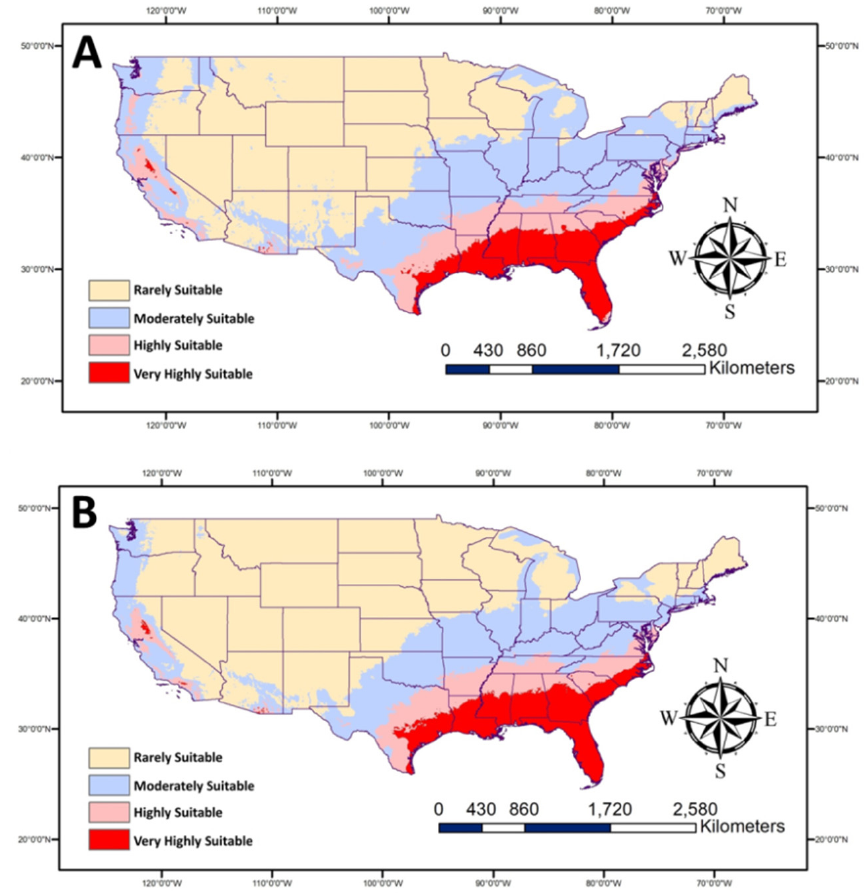
Figure 5. Map showing future habitat suitable for Plecia nearctica in the USA during 2050. The average of two future models (BCC-CSM2-MR and MRI-ESM2-0) for ( A ): SSP 126 and ( B ): SSP